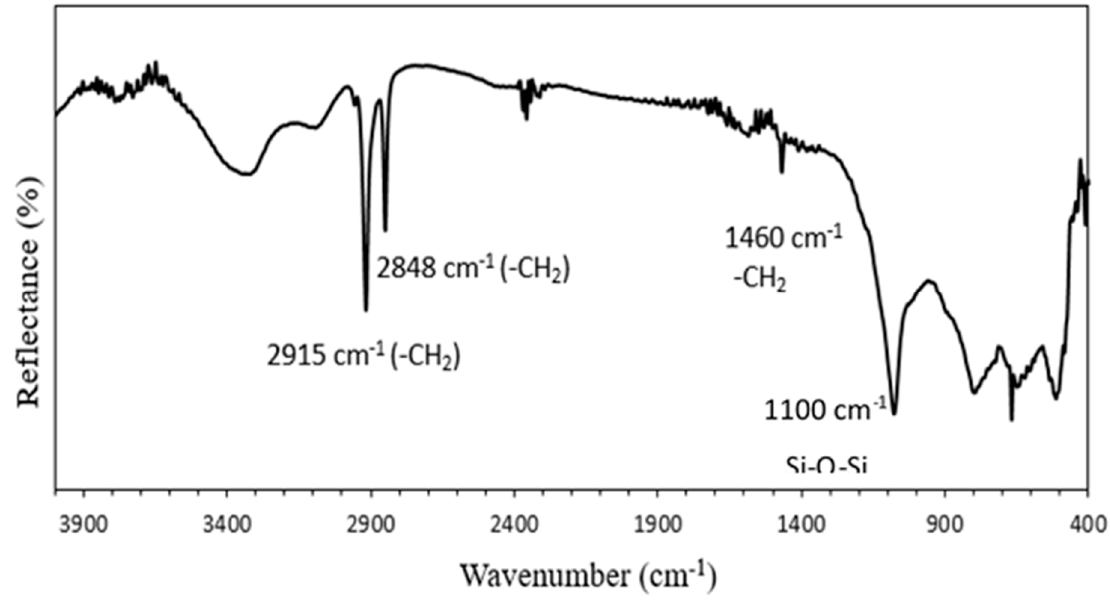
Figure 4. FTIR spectra of A-WS surface.